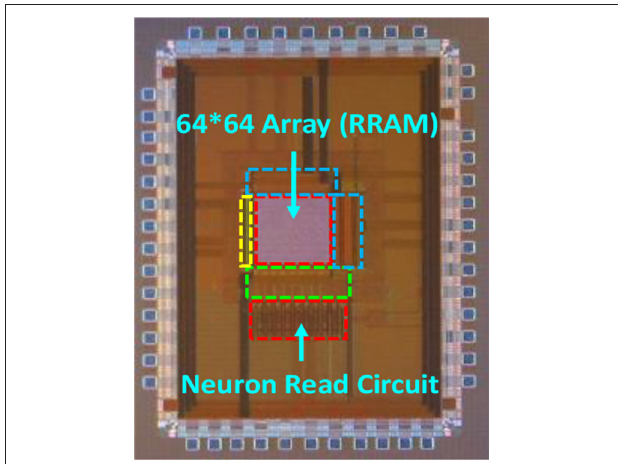
FIGURE 22 | Crossbar macro die.